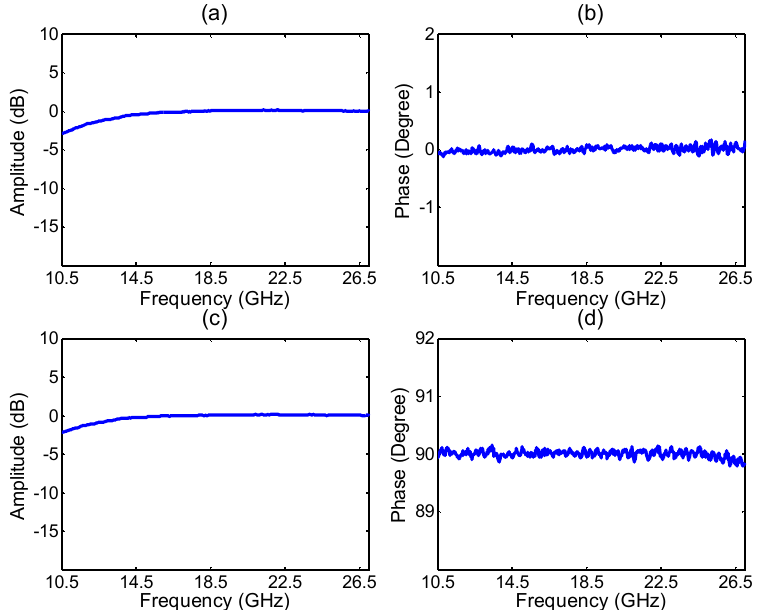
Figure 12. ( a ) The amplitude and ( b ) phase response of the I-phase channel, and ( c ) amplitude and ( d ) phase response of the Q-phase channel of the 90° hybrid coupler.